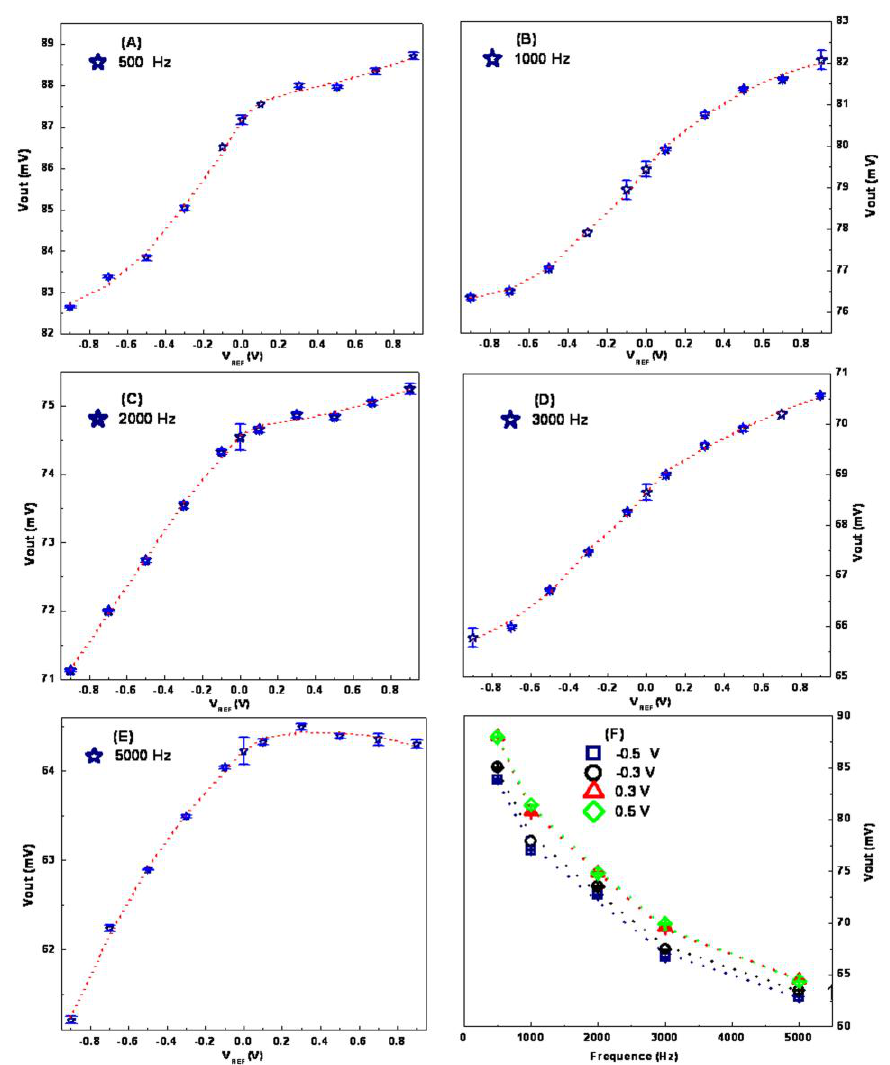
Figure 2. Basic electronic features of LAPS when the illumination was modulated with frequency ( A ) 500 Hz, ( B ) 1000 Hz, ( C ) 2000 Hz, ( D ) 3000 Hz and ( E ) 5000 Hz. ( F ) The influences of the illumination’s modulating frequencies were examined.